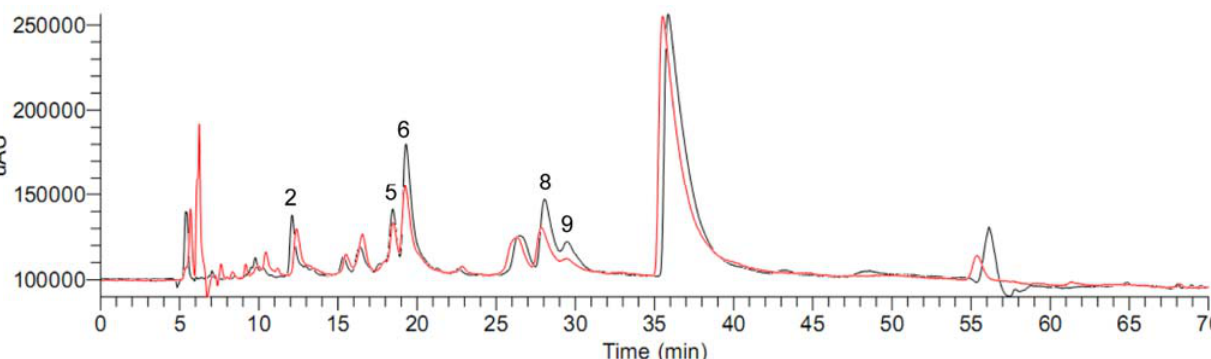
Figure 4. HPLC chromatograms before (black) and after (red) incubation of the dichloromethane extract of C. yanhusuo with